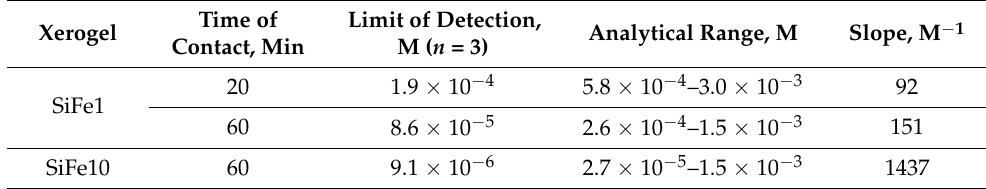
Table 2. Analytical characteristics of salicylhydroxamic acid determination.